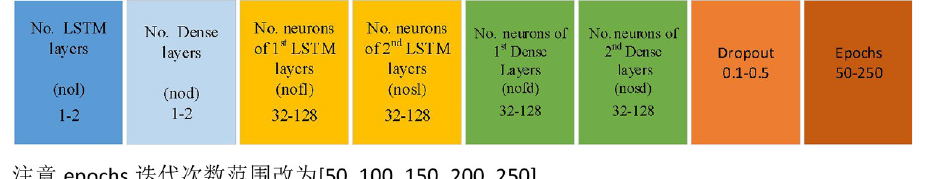
Fig 6. Chromosome of adaptive genetic